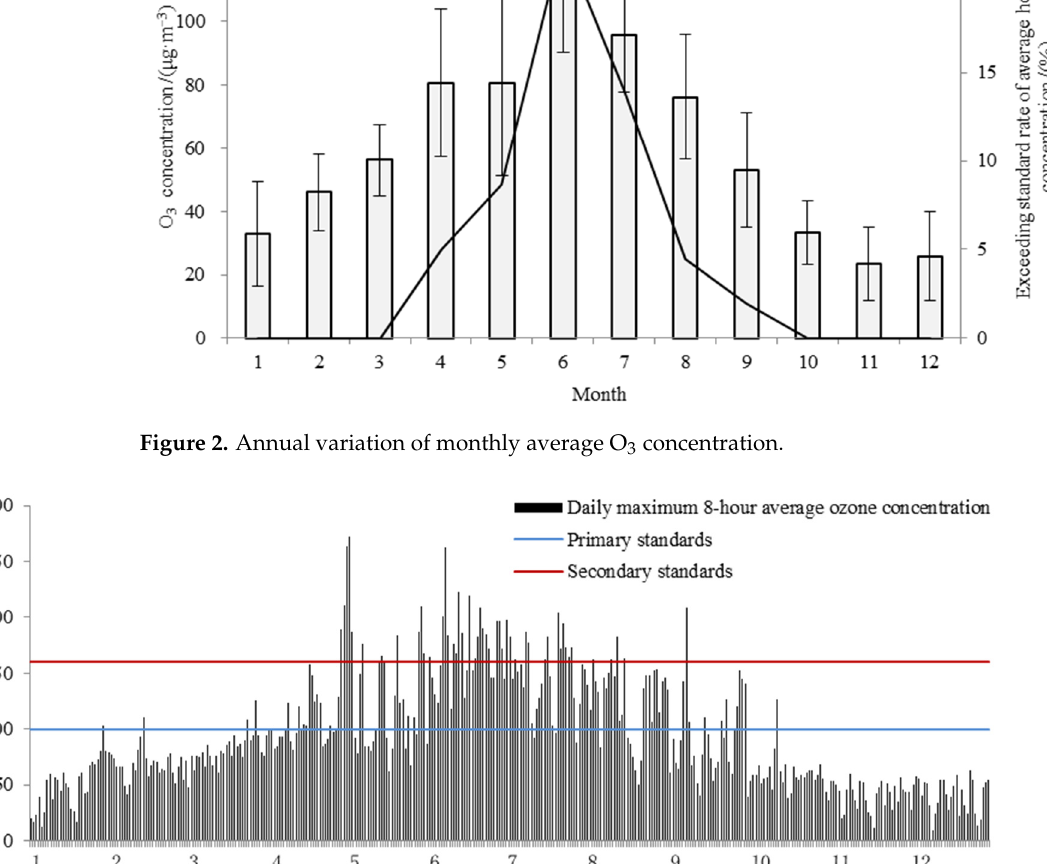
Figure 3. Annual variation of the daily maximum 8 h average ozone concentration. (Note: month value is plotted at the start of each month).